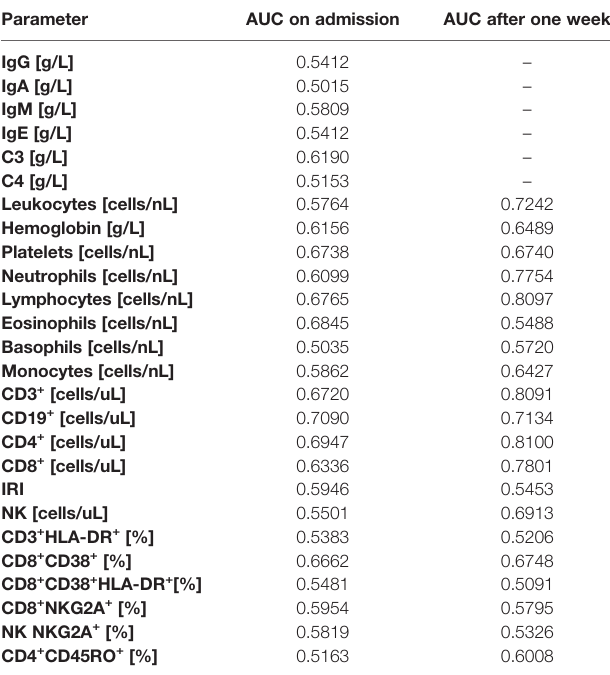
TABLE 4 | Area under the ROC curve (AUC) values for examined parameters on admission and after one week. Parameter